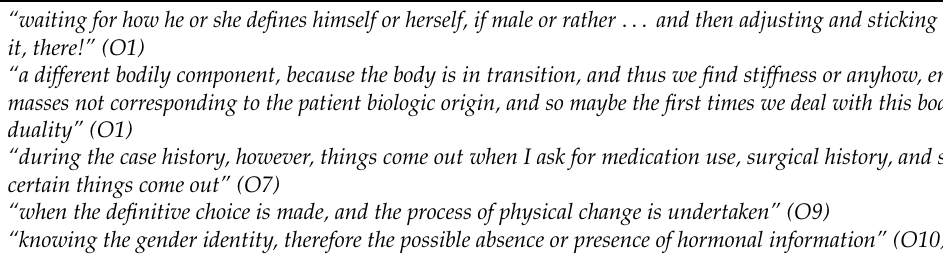
Table 6. The idea of transgender people only as binary and